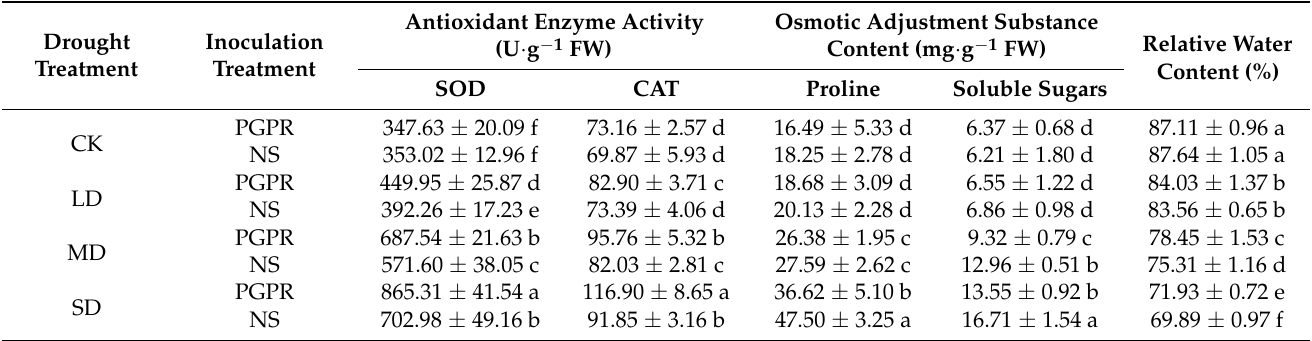
Table 2. Effects of different drought and inoculation treatments on the antioxidant enzyme activities, osmotic adjustment substance content, and relative water content of walnut seedlings (Mean ±